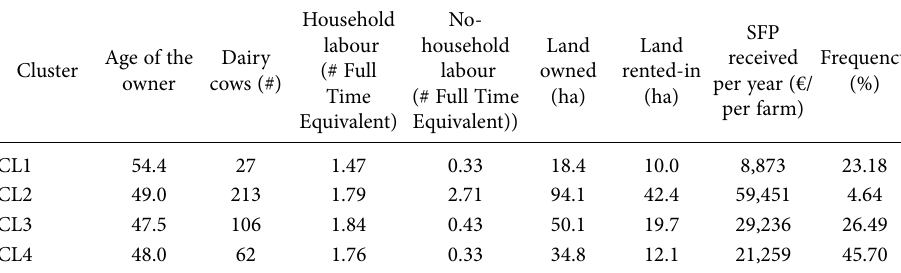
Table 1. Group Characteristics and Frequencies